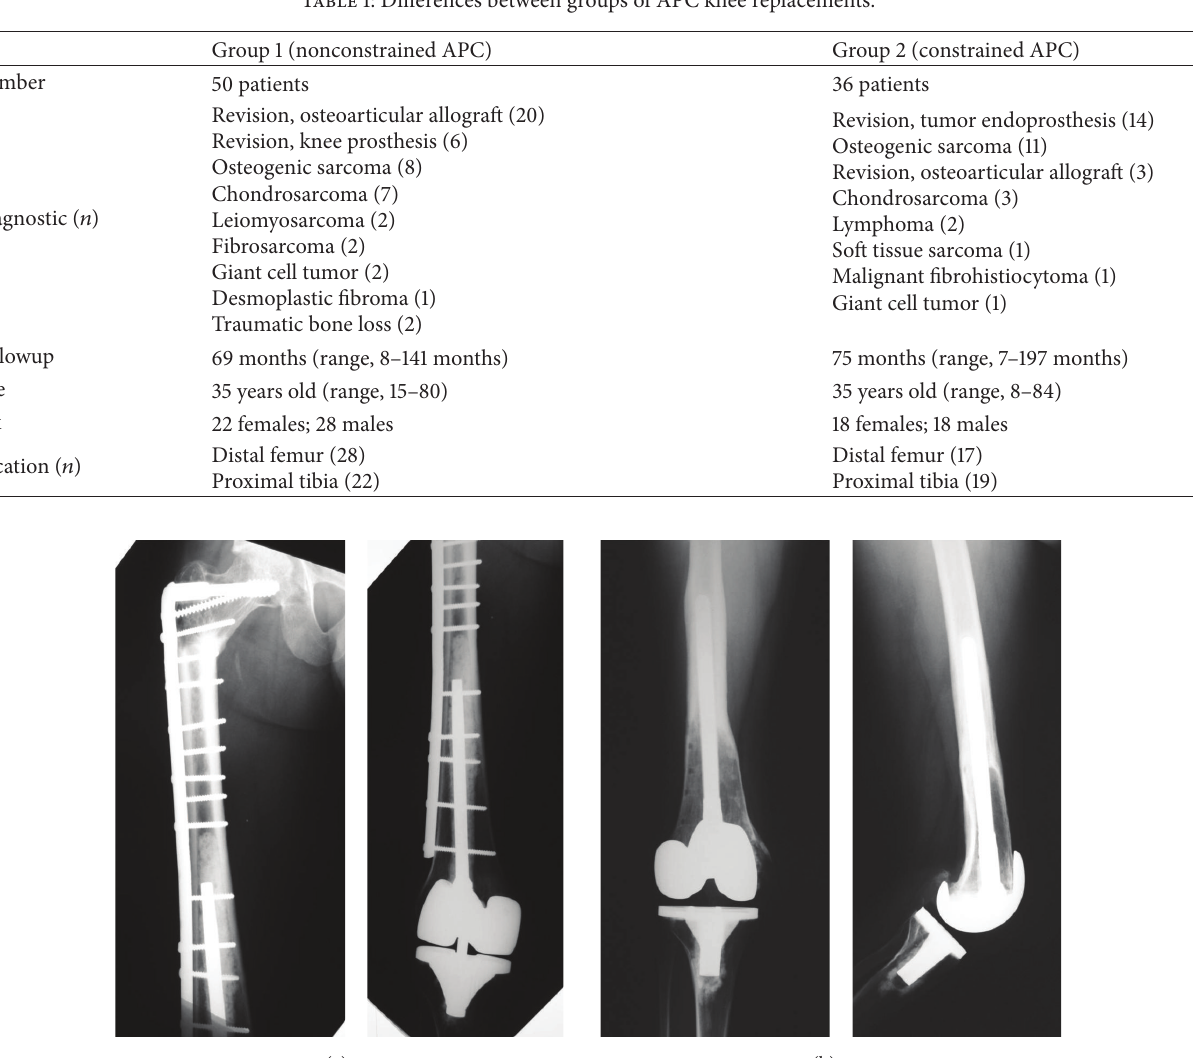
Table 1: Differences between groups of APC knee replacements.